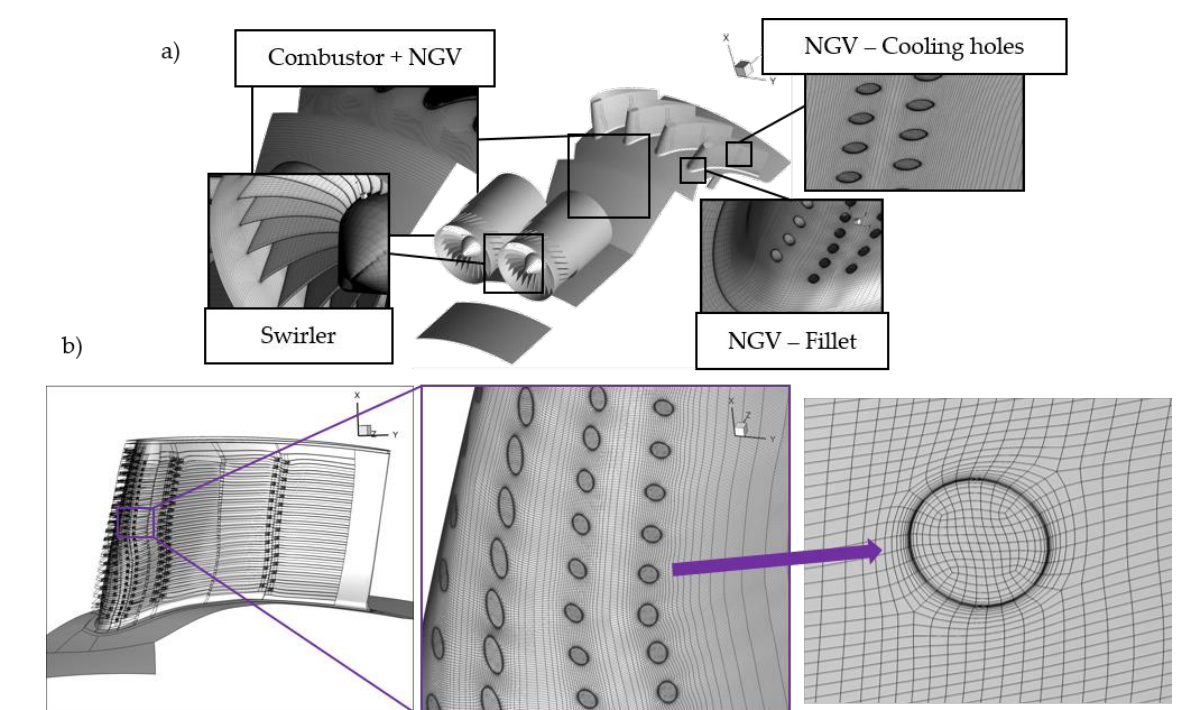
Figure 5. General view of the computational mesh ( a ) and NGV cooling holes ( b ). Table 2. Boundary conditions at multiperforated walls.